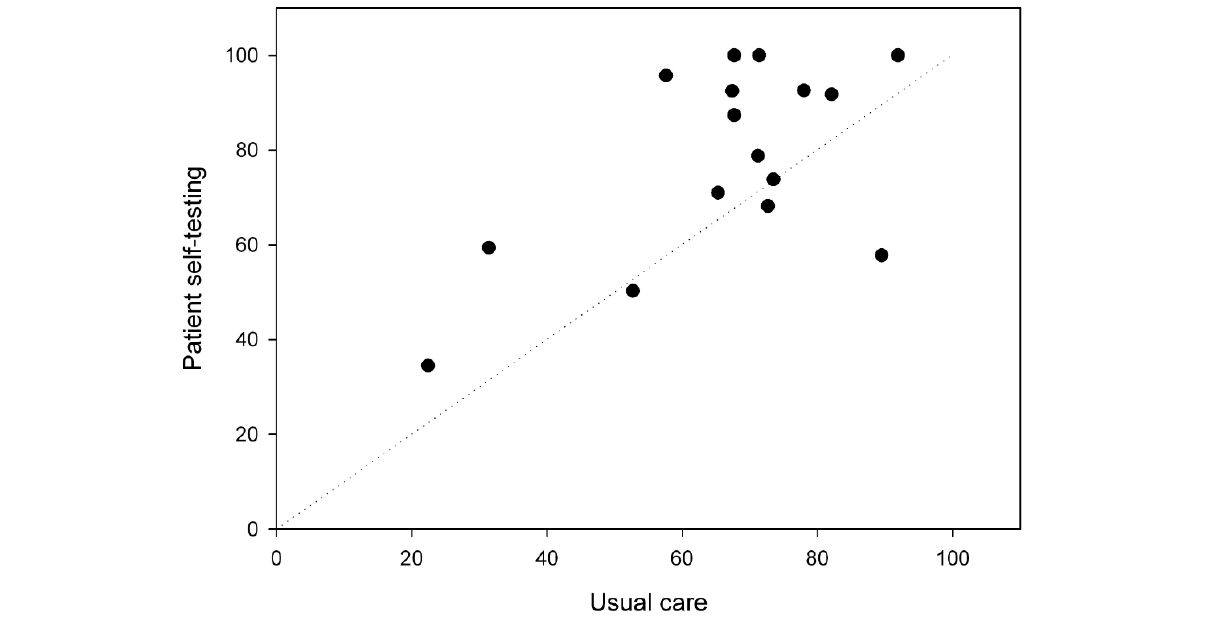
Figure 3. Percentage of time in therapeutic range for patient self-testing vs usual